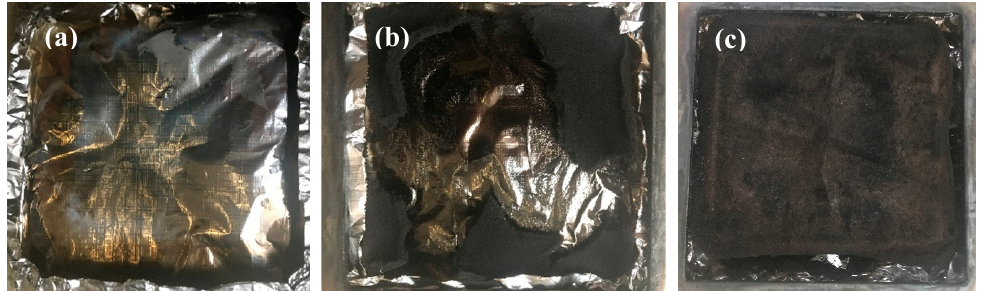
Figure 11. Digital photographs of residues of ( a ) HCNF, ( b ) HCNF/APP, and ( c ) HCNF/APP/MTMS aerogels after the cone calorimeter test.